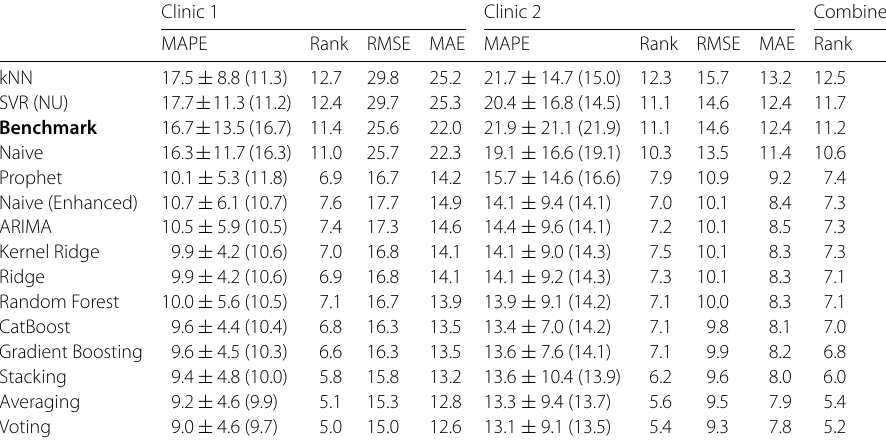
Table 4 Forecast accuracies by algorithm and clinic using all features as well as MAPE accuracies of models using only autoregressive features in parentheses. Ranks per clinic are based on MAPE and are also combined across